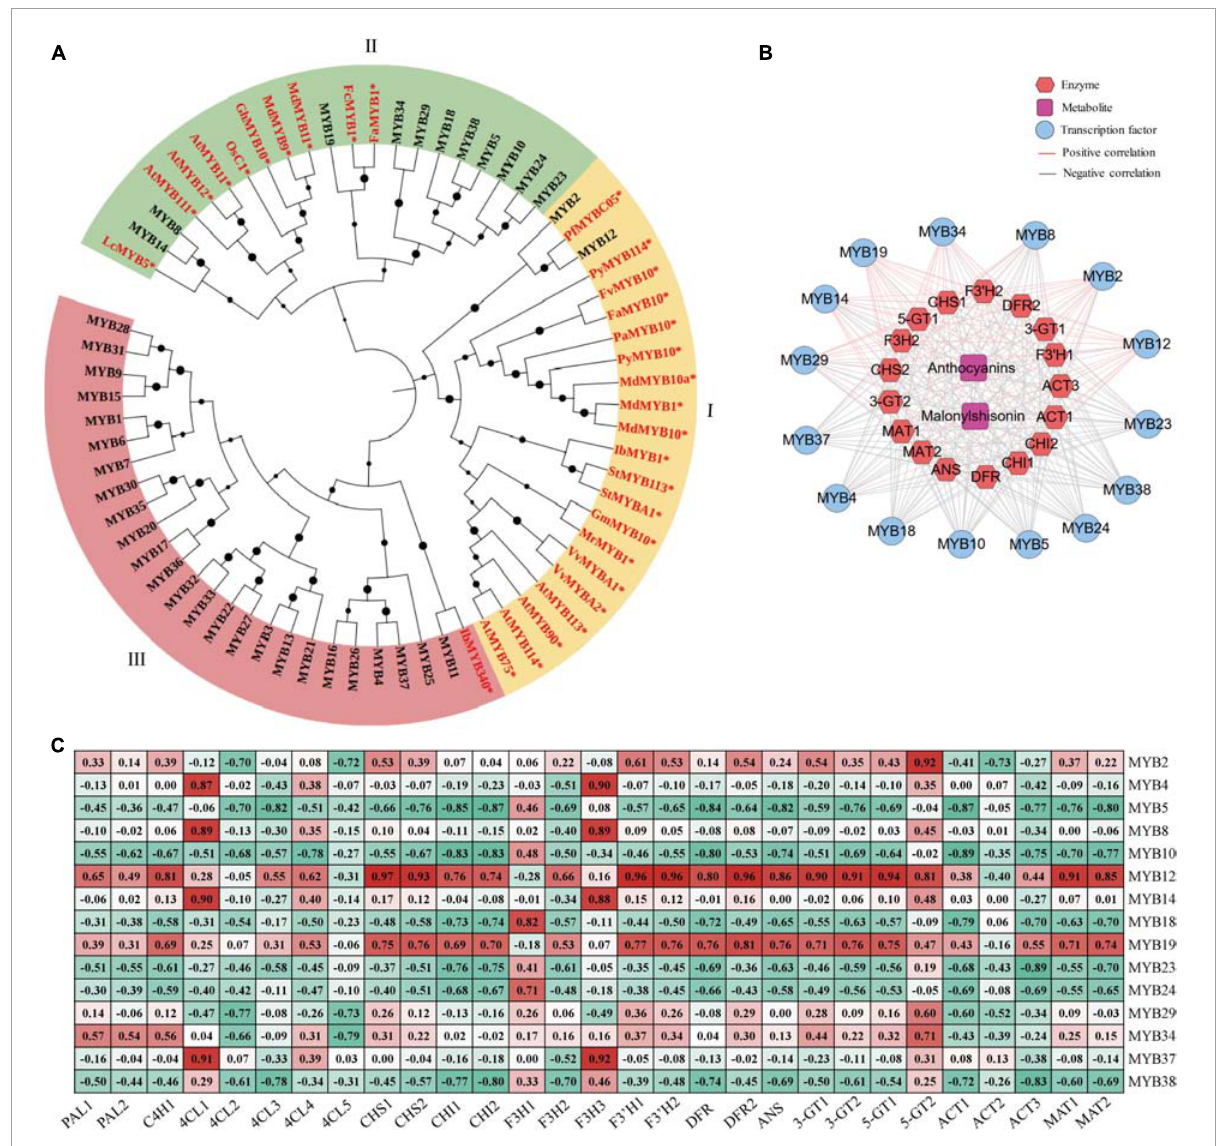
FIGURE6 The MYB transcription factors involved in anthocyanin biosynthesis in perilla. (A) Phylogenetic relationships of MYBs between perilla and other plants. Yellow, green, and pink background indicate three subclasses in the evolutionary tree. The dots next to the nodes represent bootstrap values of 1000 replicates. The red font and symbol ∗ indicate that these objects have been reported. (B) Co-expression networks between candidate MYBs. (C) Correlation coefficients between candidate MYB transcription factors and key anthocyanin biosynthesis genes. At, Arabidopsis thaliana ; Vv, Vitis vinifera ; St, Solanum tuberosum ; Pb, Pyrus x bretschneideri ; Os, Oryza sativa Japonica; Pf, Perilla frutescens var. crispa ; Pa, Prunus avium ; Py, Pyrus pyrifolia var. culta ; Mr, Morella rubra ; Md, Malus domestica ; Lc, Litchi chinensis ; Ib, Ipomoea batatas ; Gh, Gossypium hirsutum ; Gm, Garcinia mangostana ; Fa, Fragaria x ananassa ; Fv, Fragaria vesca ; Fc, Fragaria chiloensis